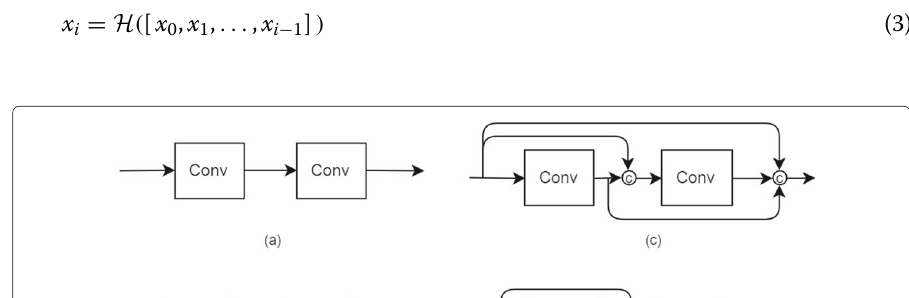
layers. Also, the output of the block consists of all levels of features from previous con- volution computation. The output of the block would be passed directly to MaxPooling layers for downsizing and further inputs. The input of the dense block is: